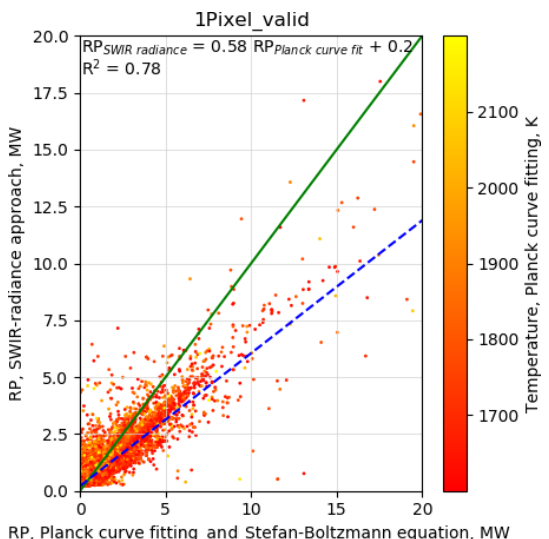
Figure 22. Comparison between the SWIR-radiance method (Fisher and Wooster, 2018) and the SLSTR-based Planck curve fit- ting. The method derived by Fisher and Wooster (2018) and ap- plied to SLSTR by Fisher and Wooster (2019) was applied to the hotspots detected by our method at flaring locations. Only detec- tions with one pixel and whose retrieved temperature was in the range considered valid for the SWIR-radiance method (between 1600 and 2200K) were considered. The continuous line represents the 1:1 relationship. The dashed line is the regression line between the